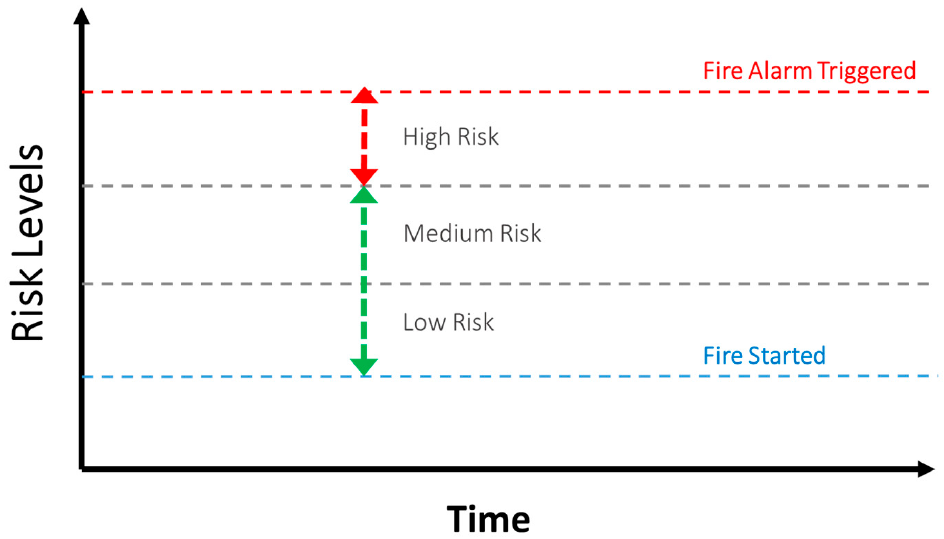
Figure 1. The data are initially captured when the fire begins continuing until the fire alarm is activated. As the fire begins, the risk level gradually increases from low to medium and then high.